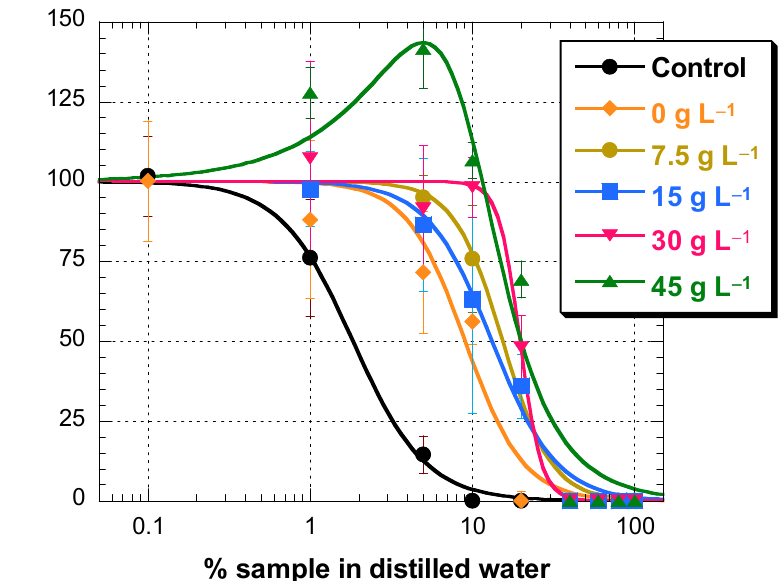
Figure 5. Germination index versus several dilutions of the digestion mixture (as volume percentages in distilled water). Samples from an undigested control (ten-fold diluted OMW), a digestate without biochar, (0 g L −1 ) and digestates with 7.5, 15, 30, 45 g L −1 of biochar.